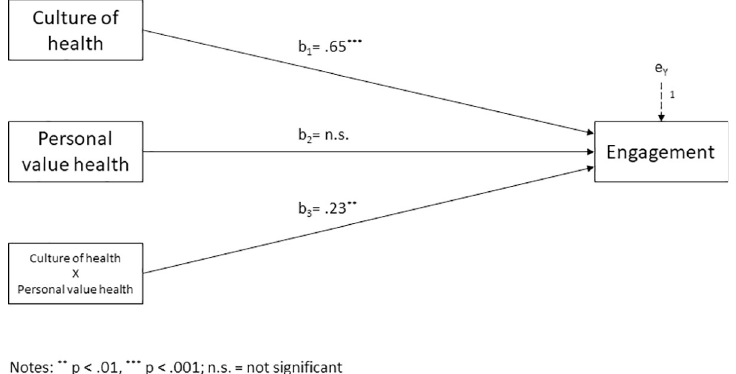
Fig 3. Moderation model. Health as personal value moderating the effect of workplace culture of health on employee